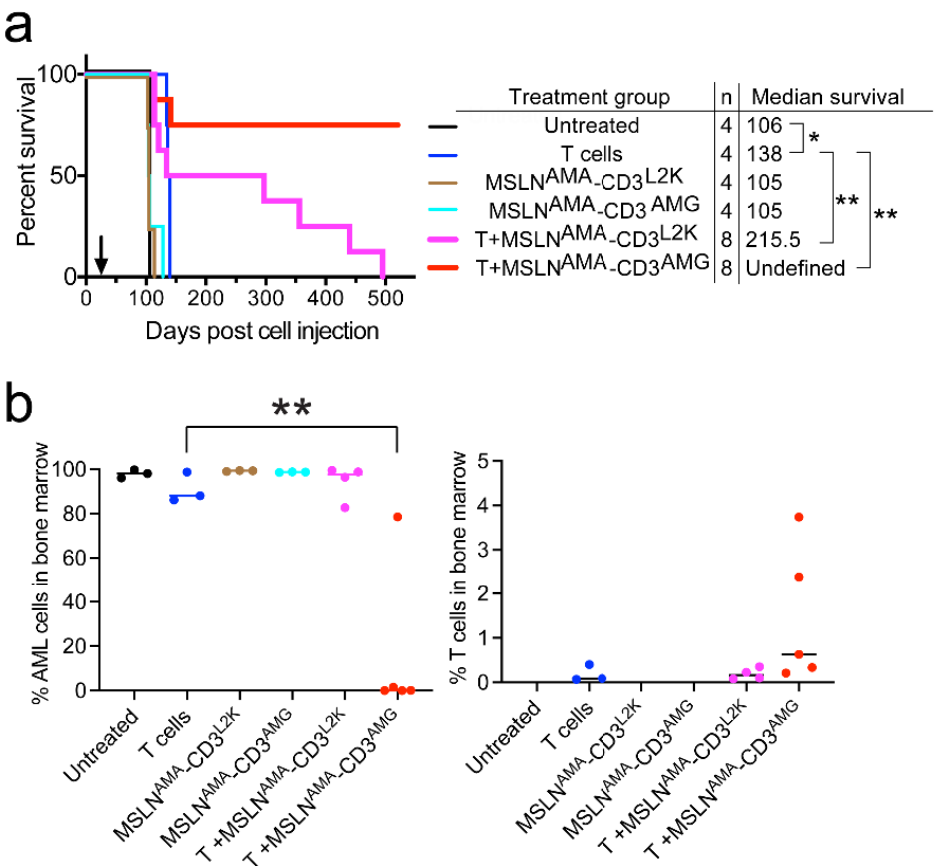
Figure 4. Validation of BsAb efficacy in NTPL-146, a MSLN-positive PDX model. ( a ), Kaplan–Meier survival plot showing the median survival. * p < 0.05; ** p < 0.001. Arrow indicates time when treatment began. ( b ), Terminal bone marrow AML load (CD45+CD3 − ) and T cell counts (CD45+CD3+) were plotted. Each dot represents data from a single mouse. Horizontal line indicates the median value. Note that mice were euthanized when they met the experimental endpoint or at the end of the experiment in case of surviving mice belonging to the T + MSLN AMA -CD3 AMG group, ** p < 0.01.